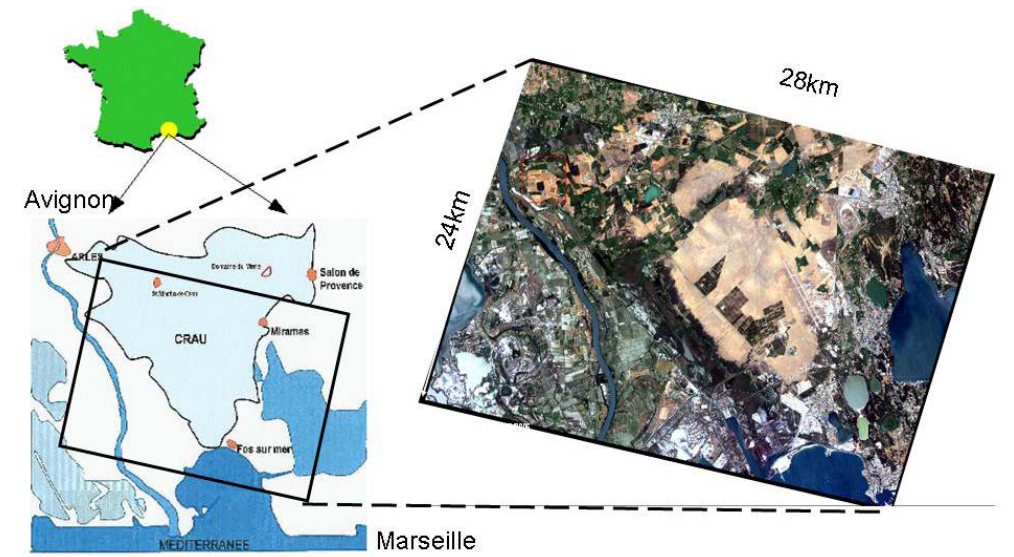
Figure 1 . Location of the studied area, and the footprint of the FORMOSAT-2 image. Fig. 1. Location of the studied area, and the footprint of the FORMOSAT-2 Fig. 1. Location of the studied area, and the footprint of the FORMOSAT-2 image.